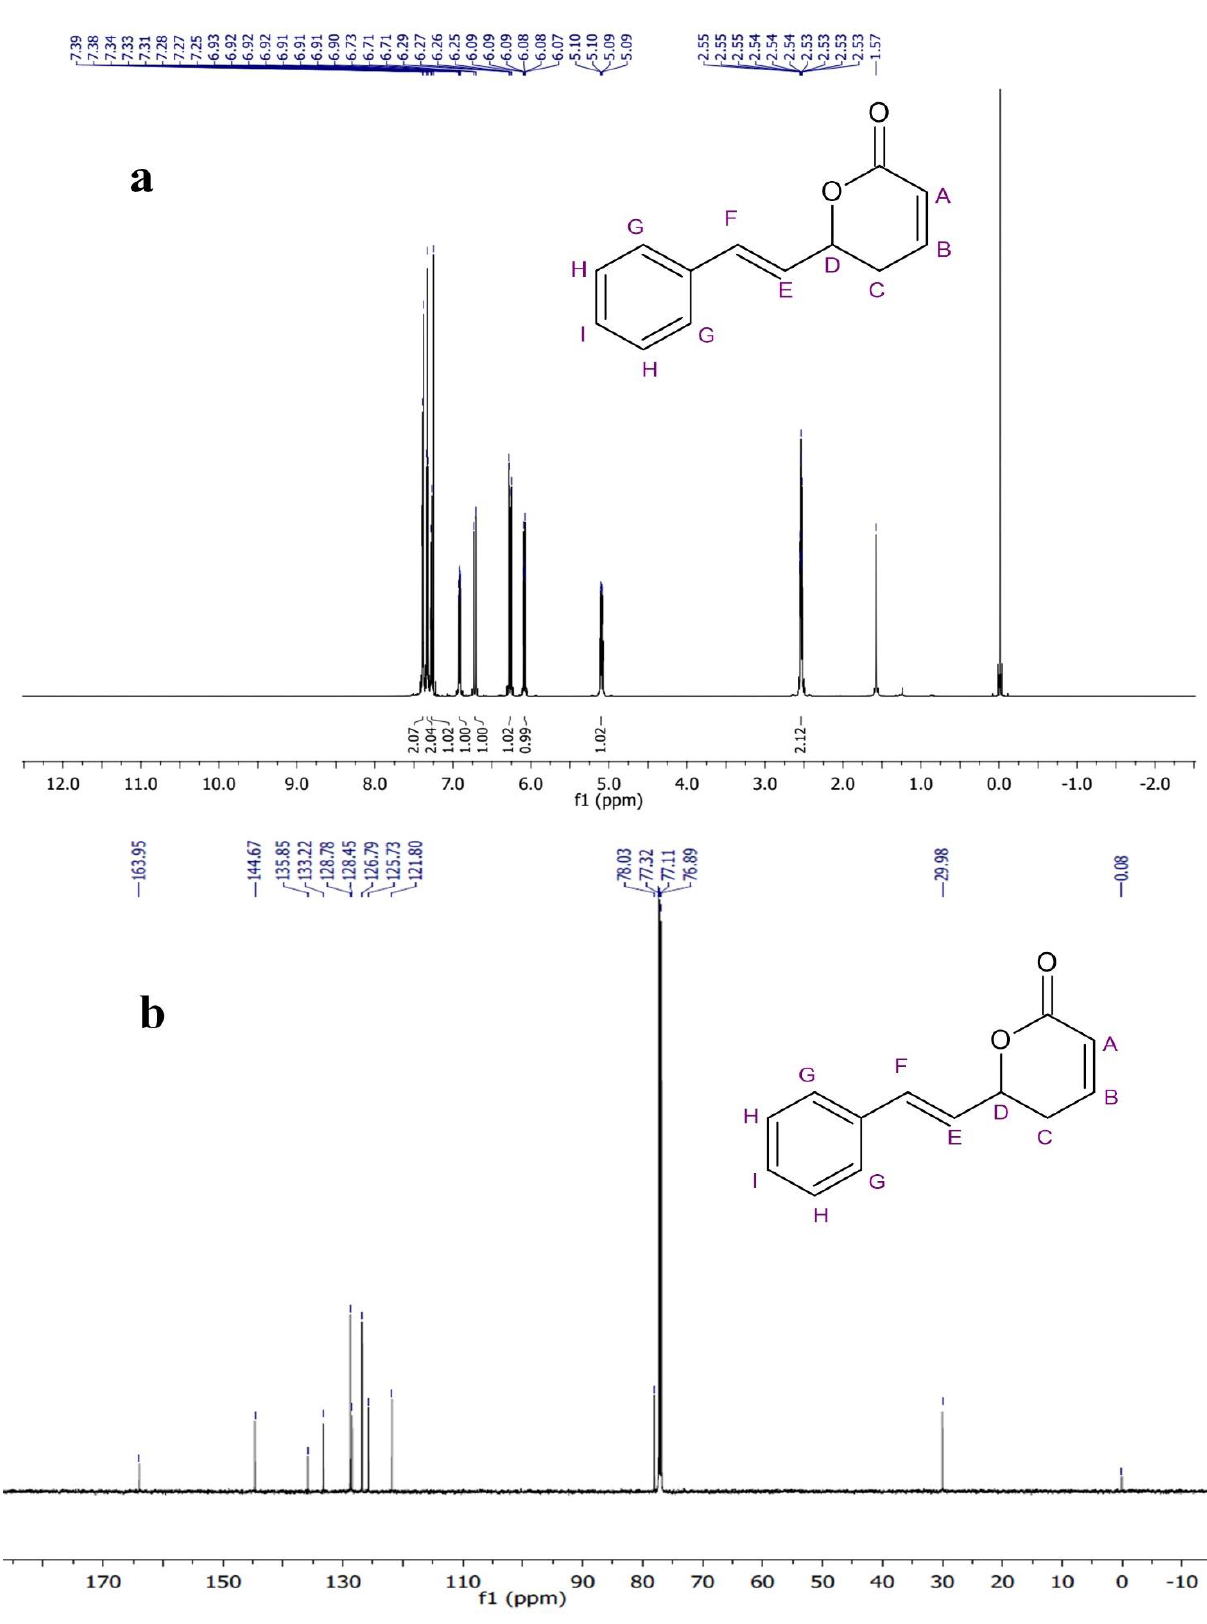
Figure 4. ( a ) 1 H-NMR and ( b ) 13 C-NMR spectra of phytocompound.